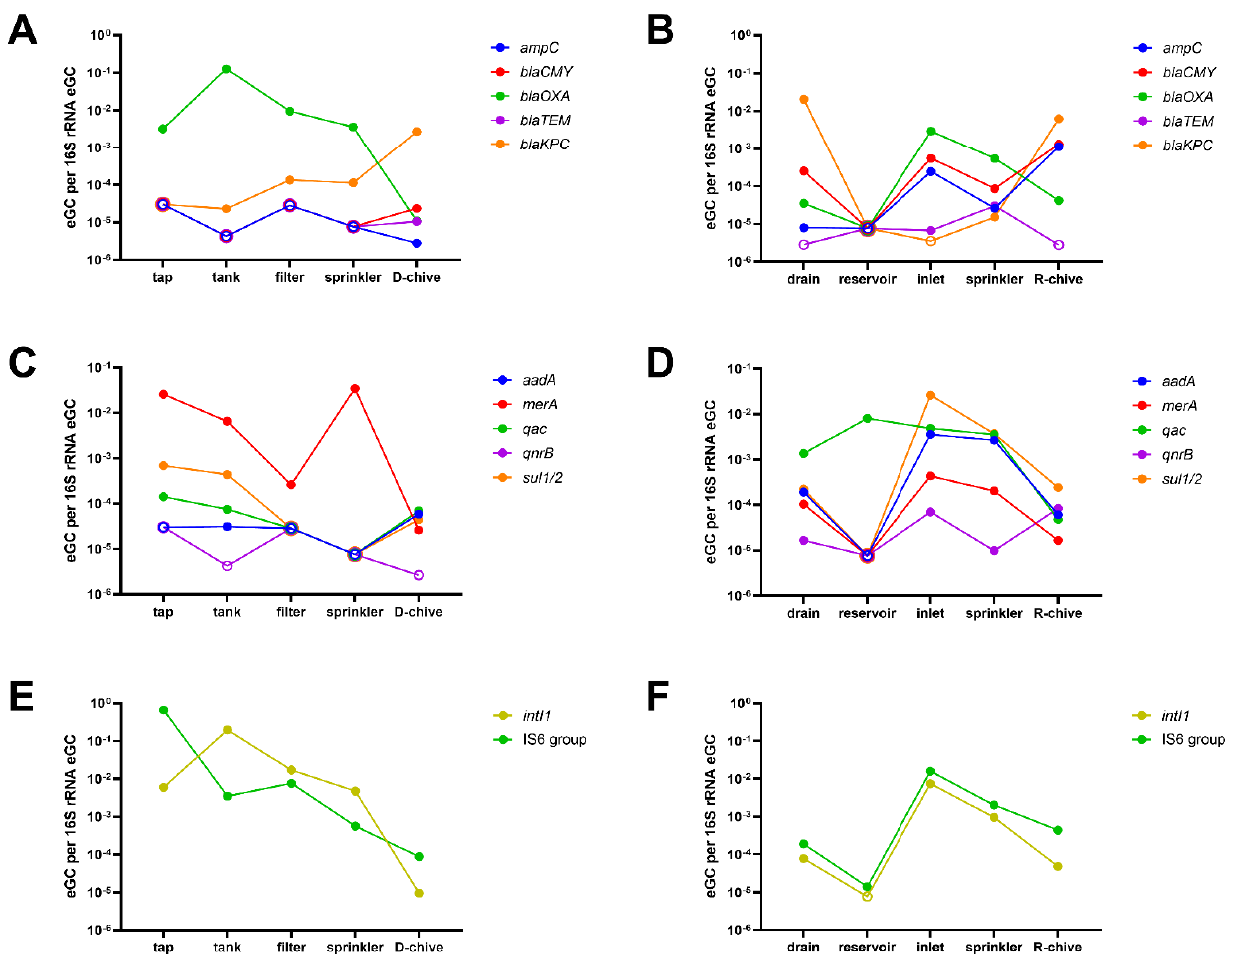
Figure 3. Estimated genomic copies (eGC) of ARGs relative to 16S rRNA eGC detected in sampling-1 along the irrigation chains. Selected single ARGs are displayed. Empty symbols mark ARGs below the limit of detection of the respective sample. ( A ) β -lactam ARGs in the D-system; ( B ) β -lactam ARGs in the R-system; ( C ) other relevant ARGs in the D-system; ( D ) other relevant ARGs in the R-system; ( E ) mobile genetic elements in the D-system; ( F ) mobile genetic elements in the R-system.